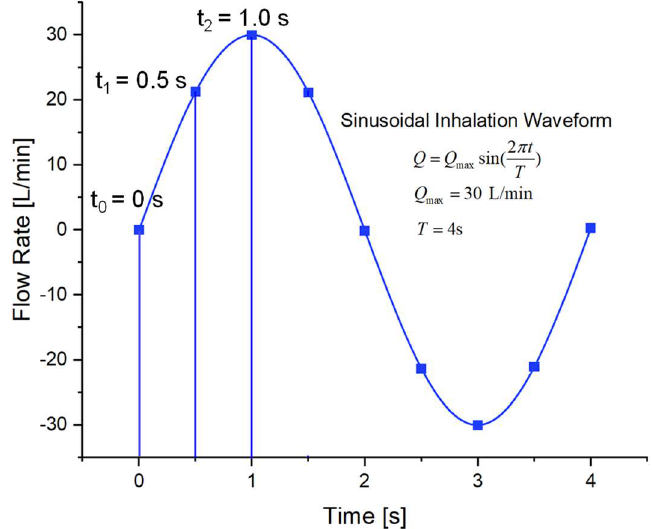
Figure 9. Sinusoidal inhalation–exhalation waveform.